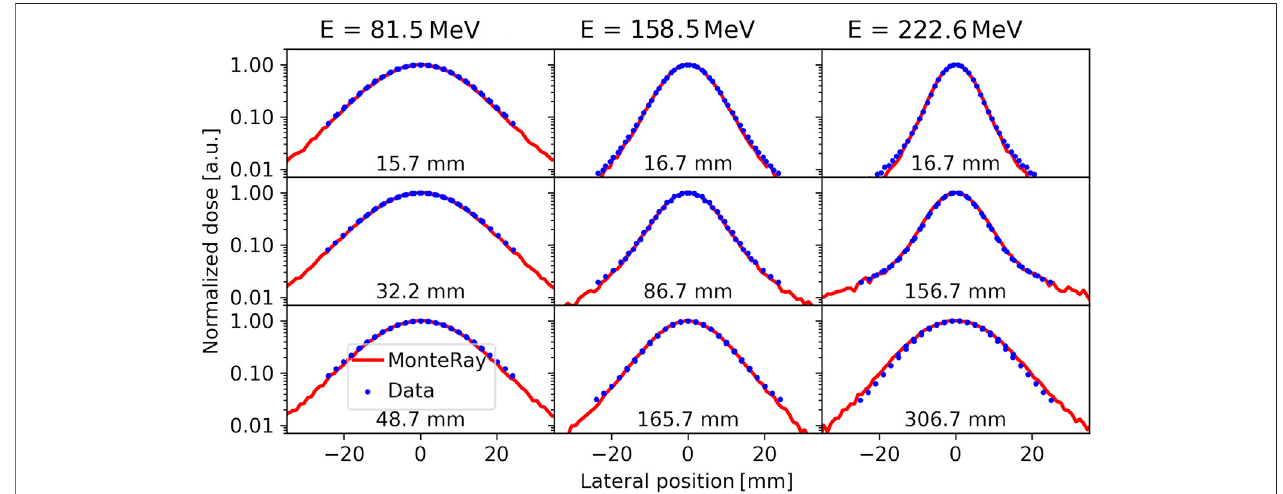
FIGURE 3 | Lateral dose pro fi les of vertically scanned proton lines at 81.5 MeV (left column) , 158.5 MeV (central column) and 222.6 MeV (right column) at different depths as reported in the panels. Measurements (blue points) are compared against MonteRay simulations (red lines).